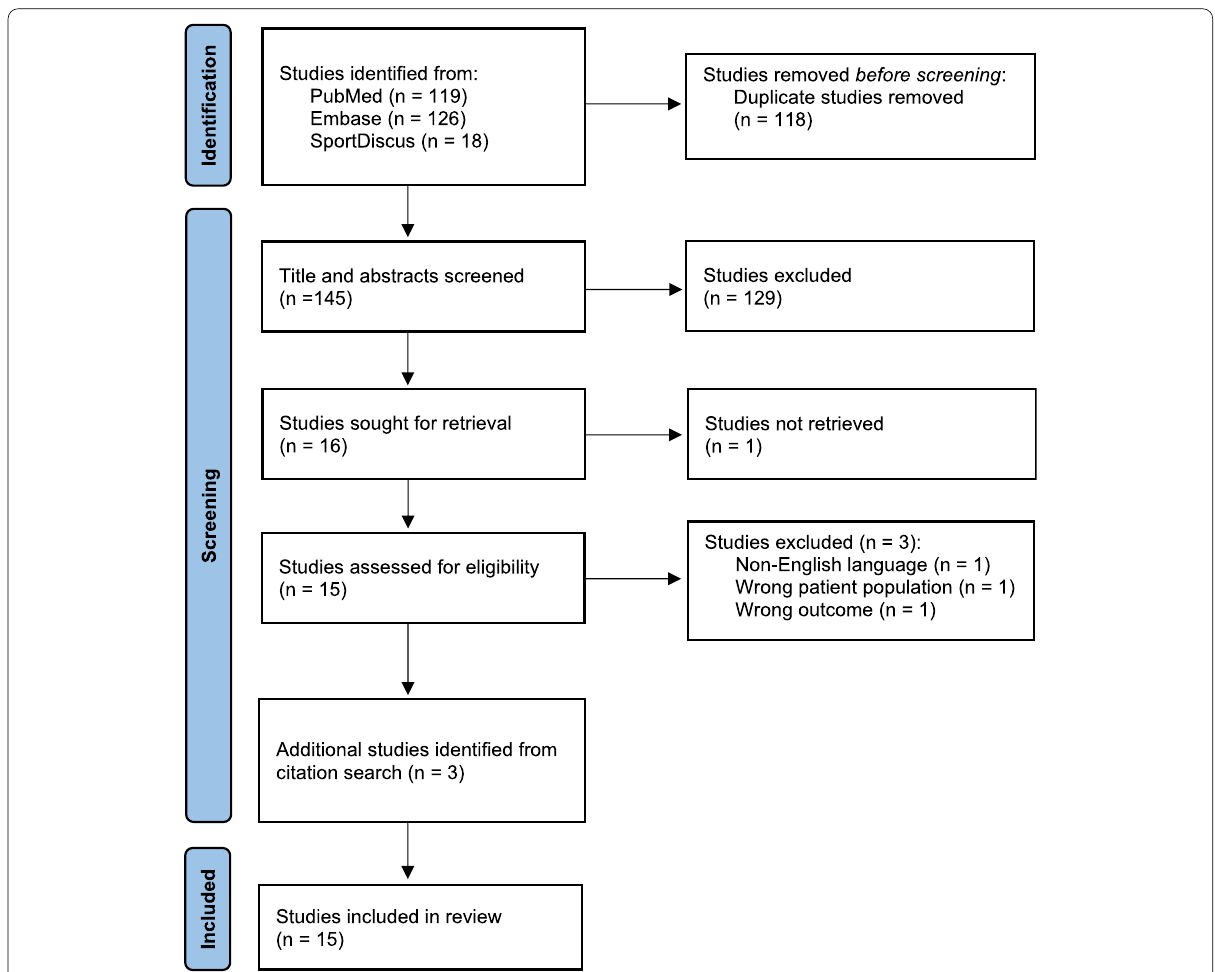
Fig. 1 Flow chart of study selection and inclusion